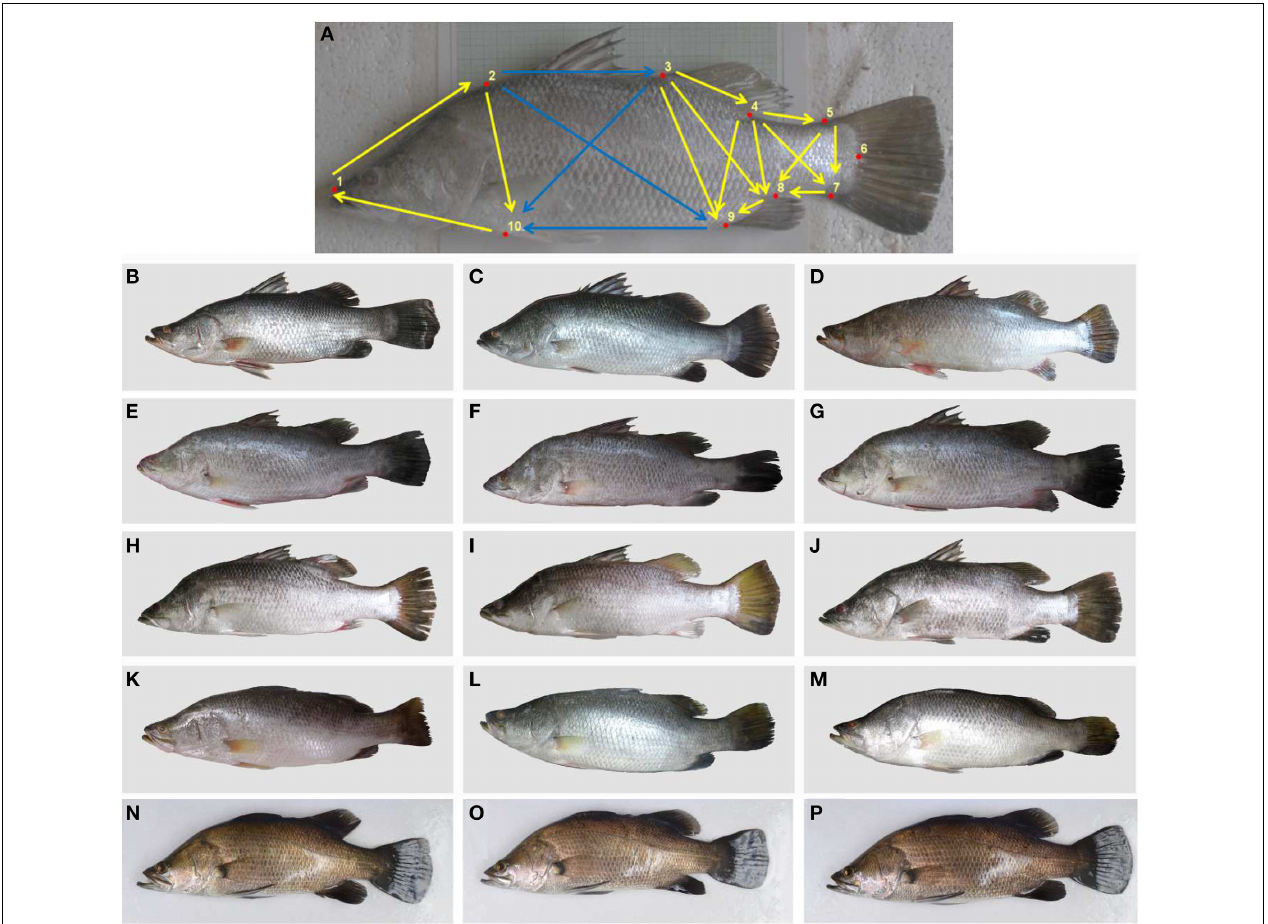
FIGURE 2 | Morphometric analyses of Asian seabass. (A) shows a representative fish with the truss measurements indicated in yellow while those truss measurements which contribute to discrimination are indicated in blue. The landmark regions are indicated as red dots and